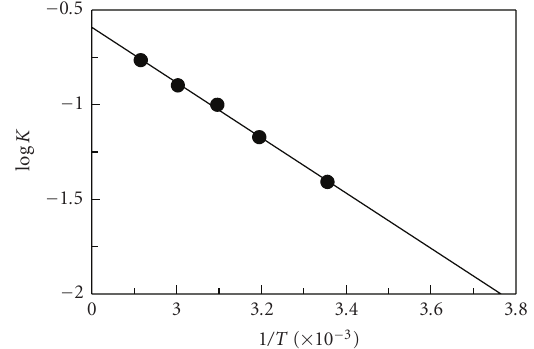
Figure 9: Arrhenius plot for the reaction of FLX with NBD-Cl. T and K are the absolute temperature and the apparent rate constant, respectively. (FLX) and (NBD-Cl) were 4 . 3 × 10 − 7 and 1 × 10 − 3 M,